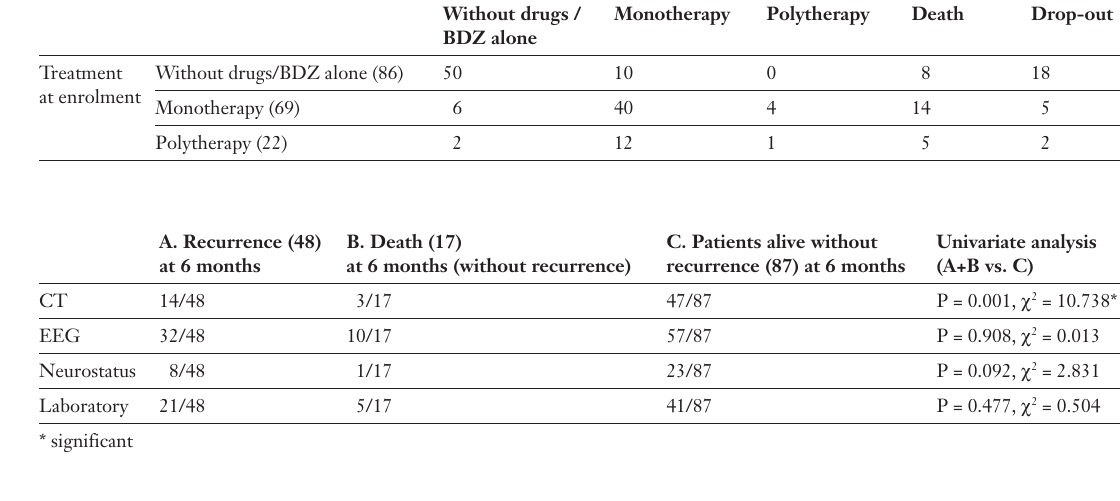
Relationship between normal complemen- tary examinations and treatment deci- sion at enrolment. The 5 CT not per- formed were con- sidered normal CT scans. OR = odds ratio (95% confidence